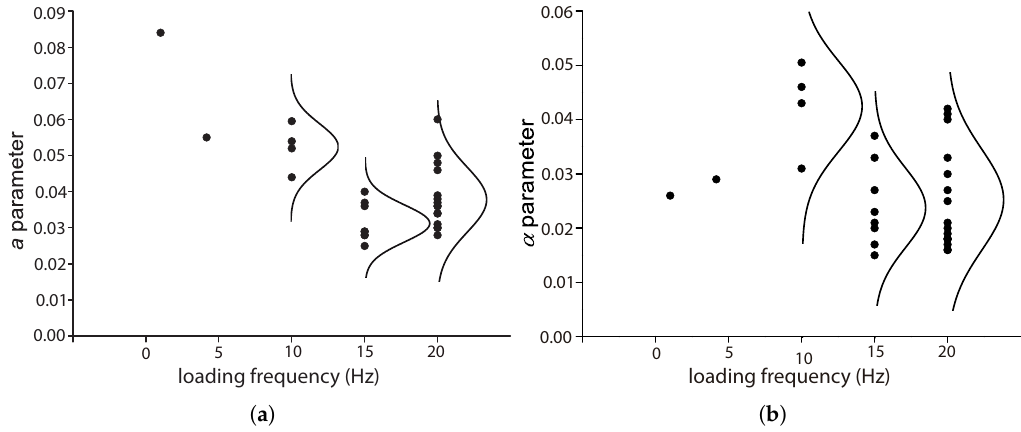
Figure 16. The variations of ( a ) a and ( b ) α with respect to the loading